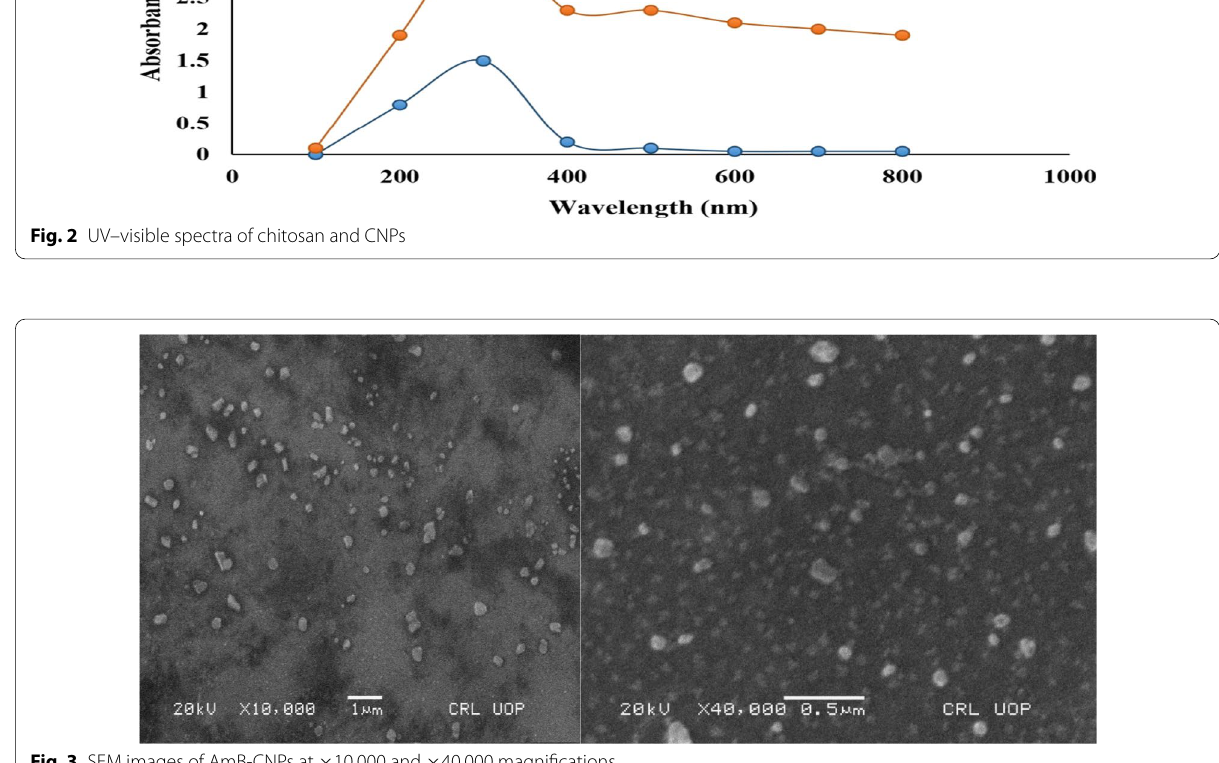
Fig. 3 SEM images of AmB-CNPs at